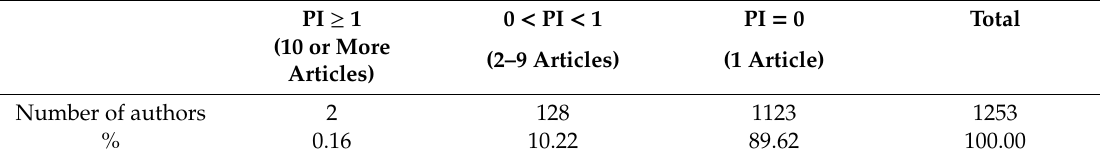
Table 2. Classification of authors based on productivity.